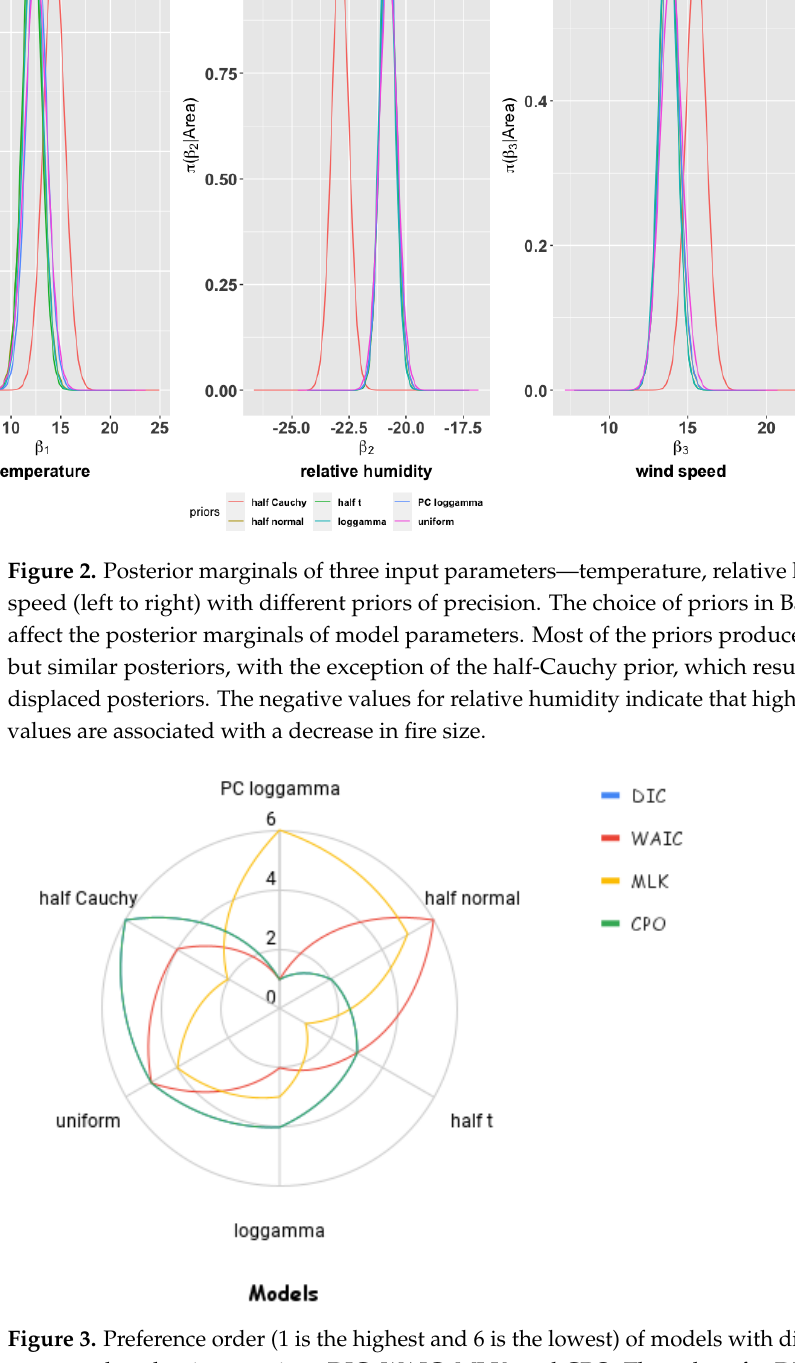
Figure 3. Preference order (1 is the highest and 6 is the lowest) of models with different priors based on several evaluation metrics—DIC, WAIC, MLK, and CPO. The values for DIC and CPO are the same, so they are represented by a single graph in the plot. Overall, the penalized complexity (PC) prior (default loggamma) had better model performance, even though it had the worst value for MLK. The Cauchy prior had the overall worst model